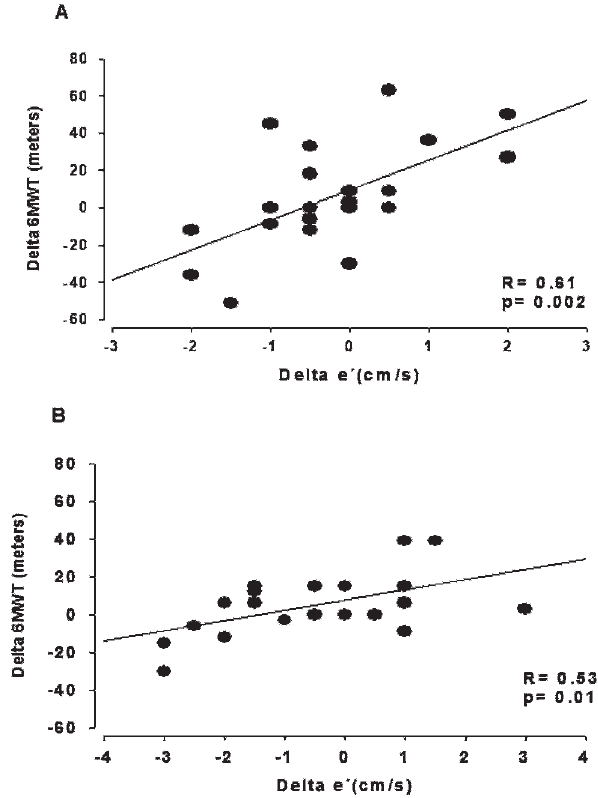
Figure 1 - Association between the variations in the diastolic function index (e 9 ) induced by CPAP (panel A) or by sham treatment (panel B) and the variation in walked